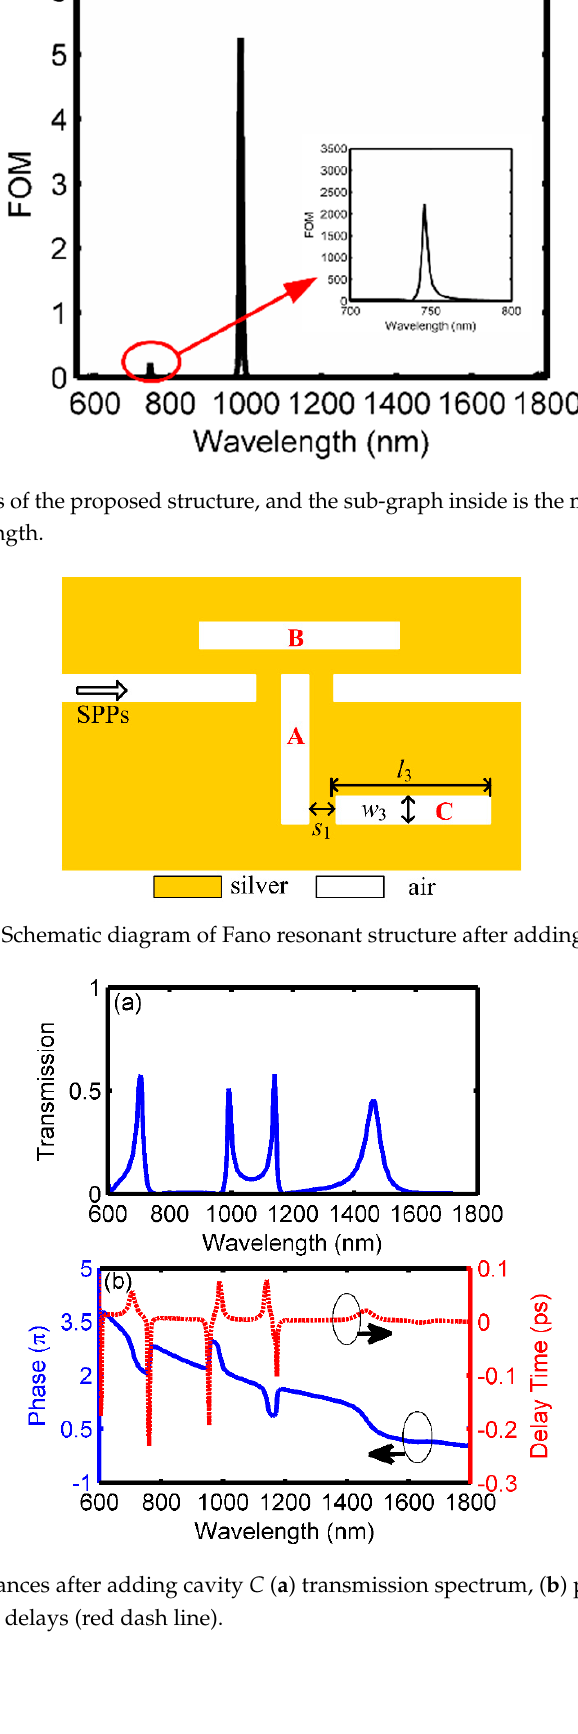
Figure 6. Fano resonances after adding cavity C ( a ) transmission spectrum, ( b ) phase responses (blue solid line) and group delays (red dash line). According to the analysis above, if one would like to obtain more Fano peaks and enhance the integration level of the device, it is suggested to design more cavities that can support the proper modes to interact with the ones in cavity A. Consequently, cavity D is added to the middle position